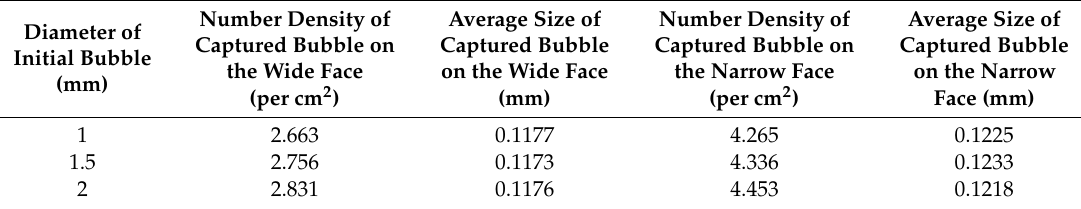
Table 8. Captured bubble distribution with di ff erent initial bubble sizes at the operation casting speed of 1.3 m / min and a gas flow rate of 4.1% gas volume